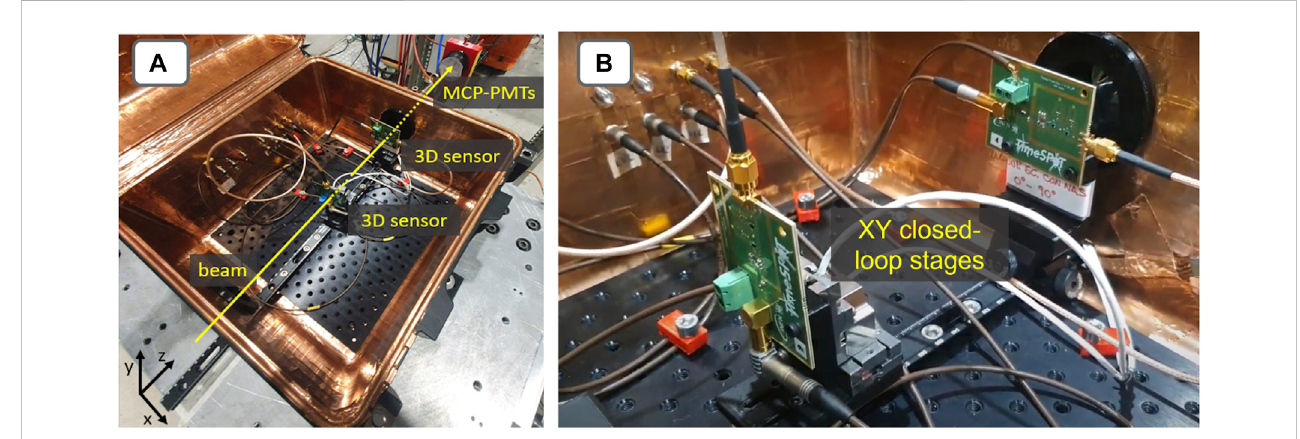
FIGURE 4 The setup used for themeasurements described in this work. (A) The sensors mounted on their FEE boards inside the RF shielded and light tight box and the two MCP-PMTs downstream; (B) Closer view of the sensors inside the box. The sensor on the right is mounted on a fi xed holder close to the beam entrance window. The sensor on the left is mounted on a movable holder driven by two closed-loop piezoelectric linear stages.